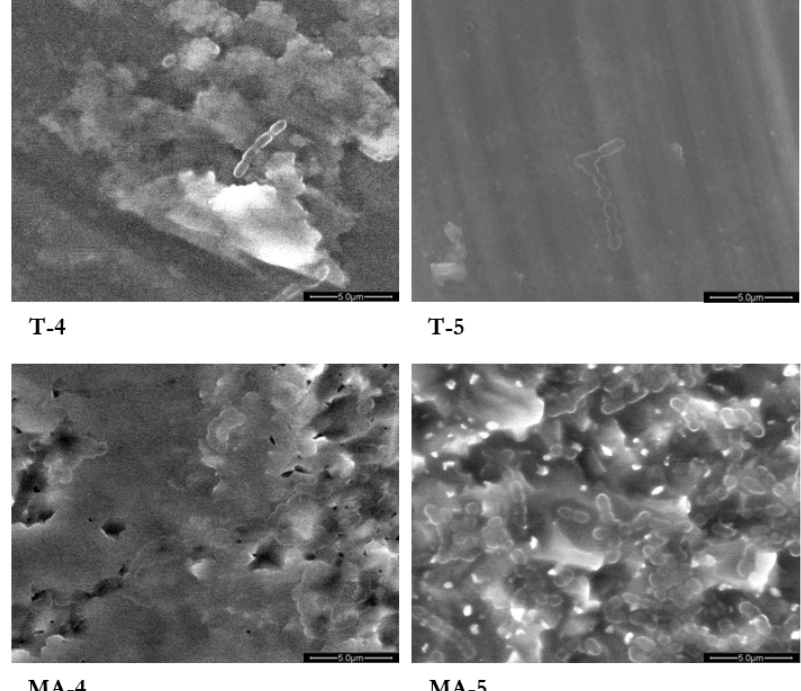
Figure 3. Environmental scanning electron microscope (ESEM) images of the turned grade 4 ( T-4 ), turned grade 5 ( T-5 ), mildly acid-etched grade 4 ( MA-4 ), and mildly acid-etched grade 5 ( MA-5 ) Ti surfaces 6 h after inoculation of a suspension of S. sanguinis . Magnification 5000×.